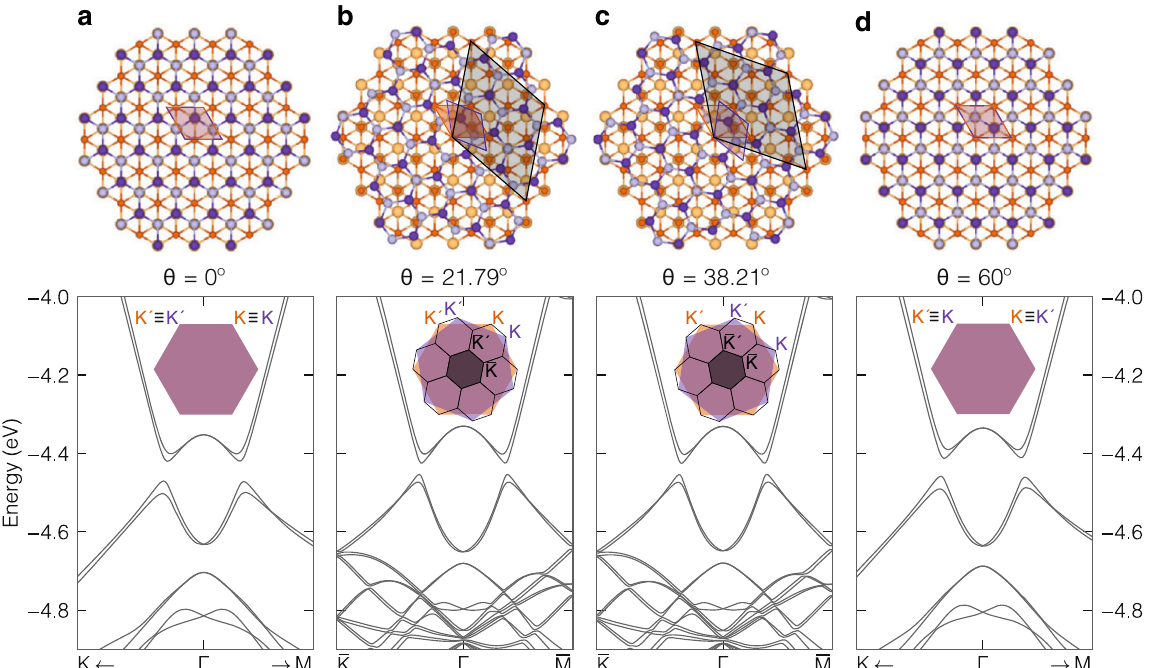
Fig. 7 Effect of relative orientation between the layers. Band structure of the In 2 Se 3 /CuI heterostructure close to the Brillouin zone center for different values of the relative rotation angle θ between the layers: 0° ( a ), 21.79° ( b ), 38.21° ( c ), and 60° ( d ). For each case, a top view of the heterostructure is reported, where the primitive unit cells of In 2 Se 3 , CuI, and the heterostructure are shown as orange, violet, and black shaded areas, respectively. For θ = 0 and 60° the heterostructure displays the same translational symmetry of the two separate layers and can thus be accommodated within a single primitive cell. On the contrary, for θ = 21.79° and 38.21° a energy gap is present between the valence and conduction bands and the system is a quantum spin Hall insulator, showing that the relative alignment between the layers has no effect on the topological classi fi cation of the heterostructure. Insets show the hexagonal Brillouin zone of In 2 Se 3 (orange), CuI (violet), and the heterostructure (black), with the inequivalent corners, K and K 0 ,